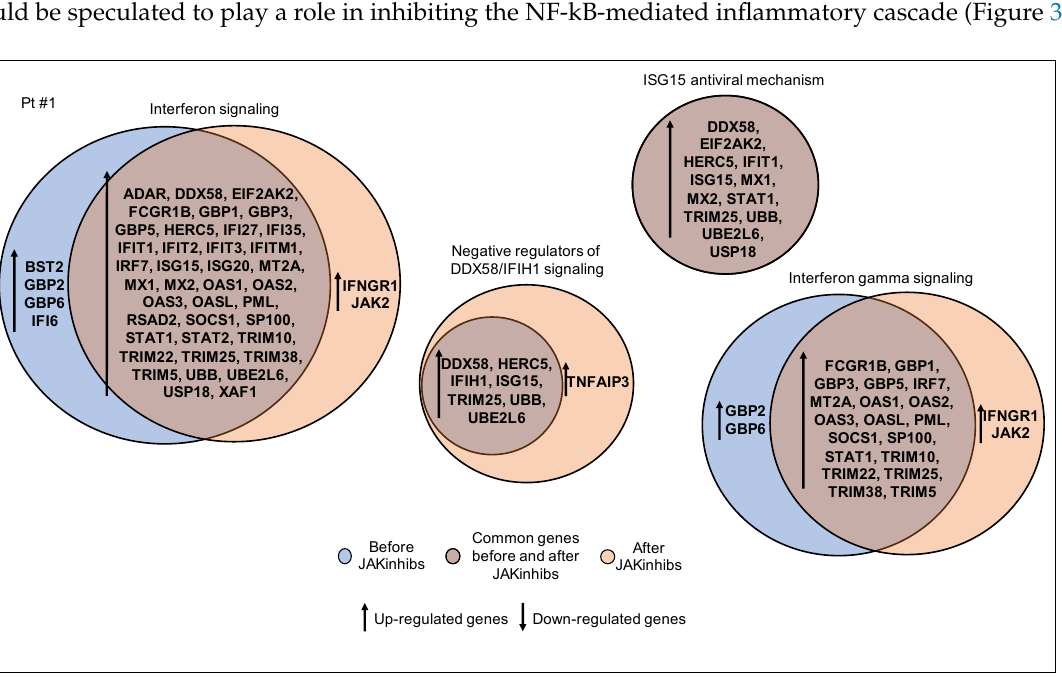
Figure 3. Pathway enrichment analysis before and after JAKinhibs treatment. Pt,